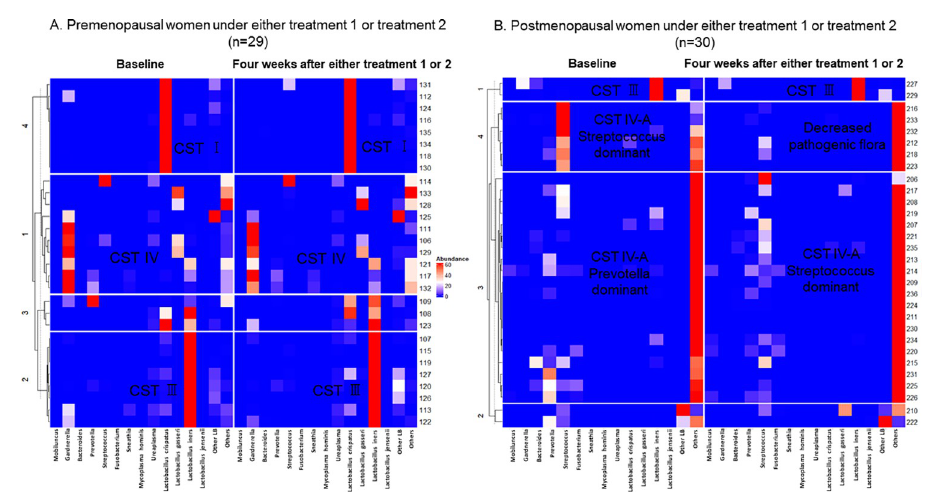
Fig 3. Distribution of pathologic flora and Lactobacillus species in the vagina at baseline and four weeks after intervention. In premenopausal women, Lactobacillus population appeared to be increased, and pathogenic flora decreased in postmenopausal women. In general, pathogenic flora population decreased in both